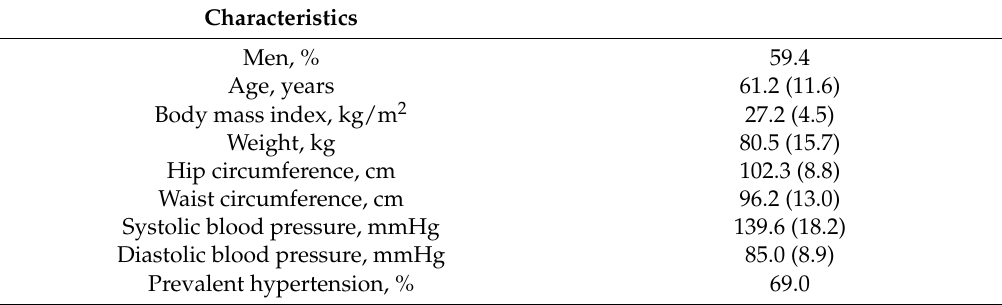
Table 1. General characteristics of the study sample ( n =